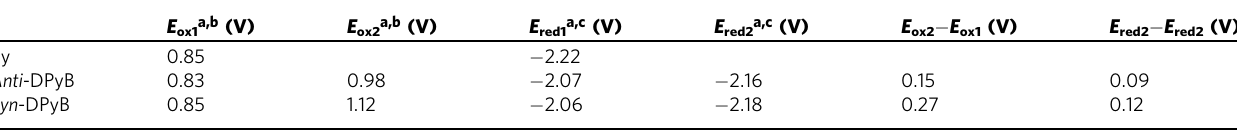
Table 3 Electrochemical parameters of Py, Anti -DPyB and Syn -DPyB evaluated by cyclic voltammograms ( E ox1 and E ox2 : fi rst and second oxidation potentials, E red1 and E red2 : fi rst and second reduction potentials).